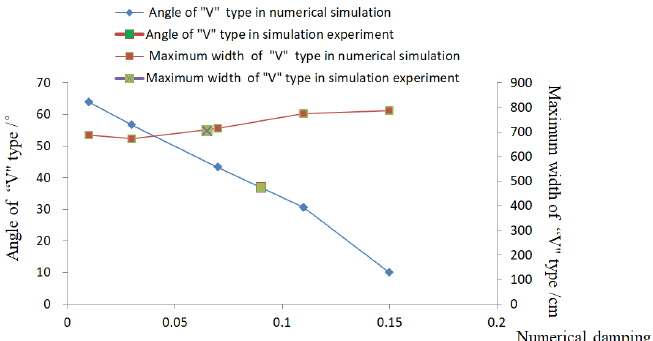
Figure 13. “V” type characteristics of coal drawing funnel of numerical simulation and simulation experiment after “medium” caving.